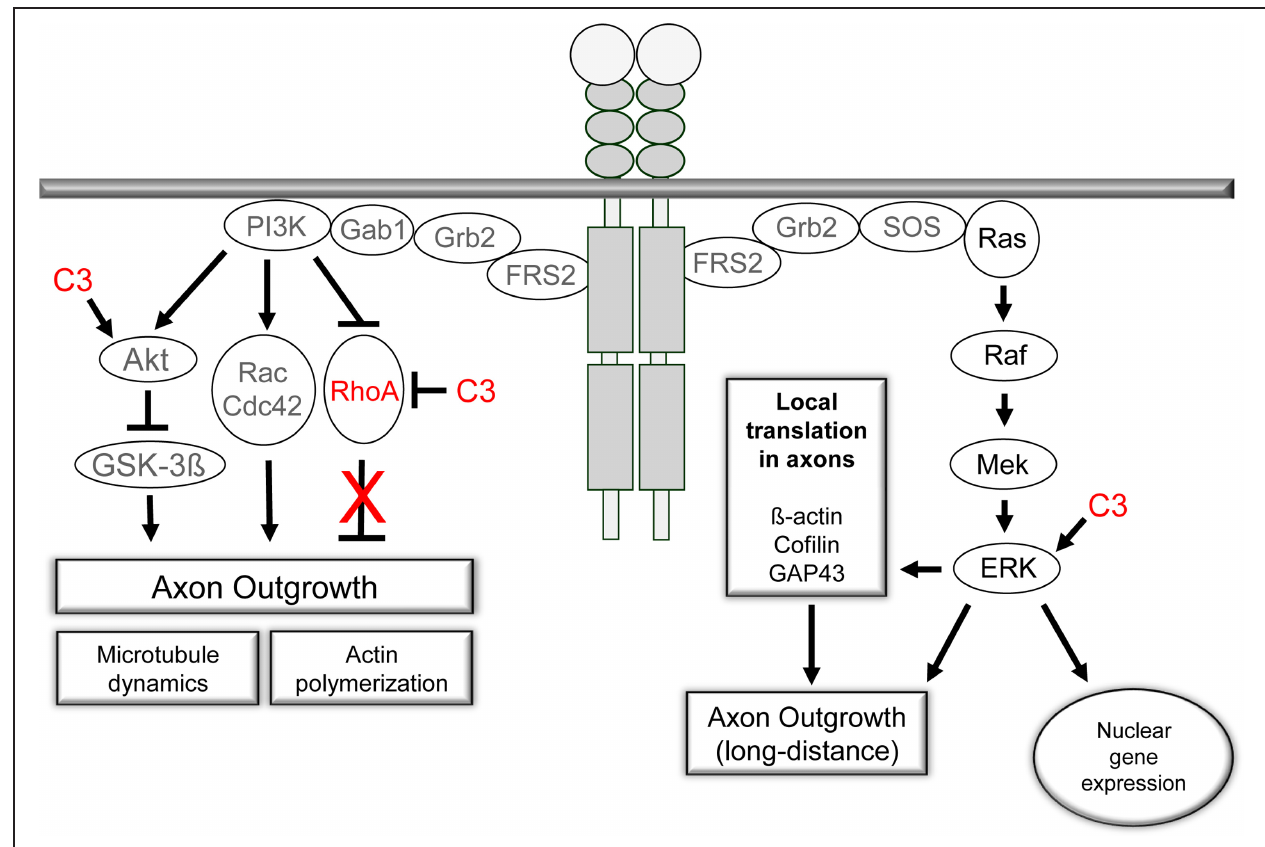
microtubule dynamics and actin polymerization. Our observations challenge the prevalent view of an inhibitory effect of RhoA activation on axonal regeneration in adult sensory neurons. Pharmacological inhibition of RhoA with C3 bot does not appear to underlie the positive effects of C3 bot on axonal regeneration. In contrast, available data suggest Rho independent means of C3 bot involving ERK/Akt signaling mechanisms probably by a non-enzymatic mode of action of C3 bot